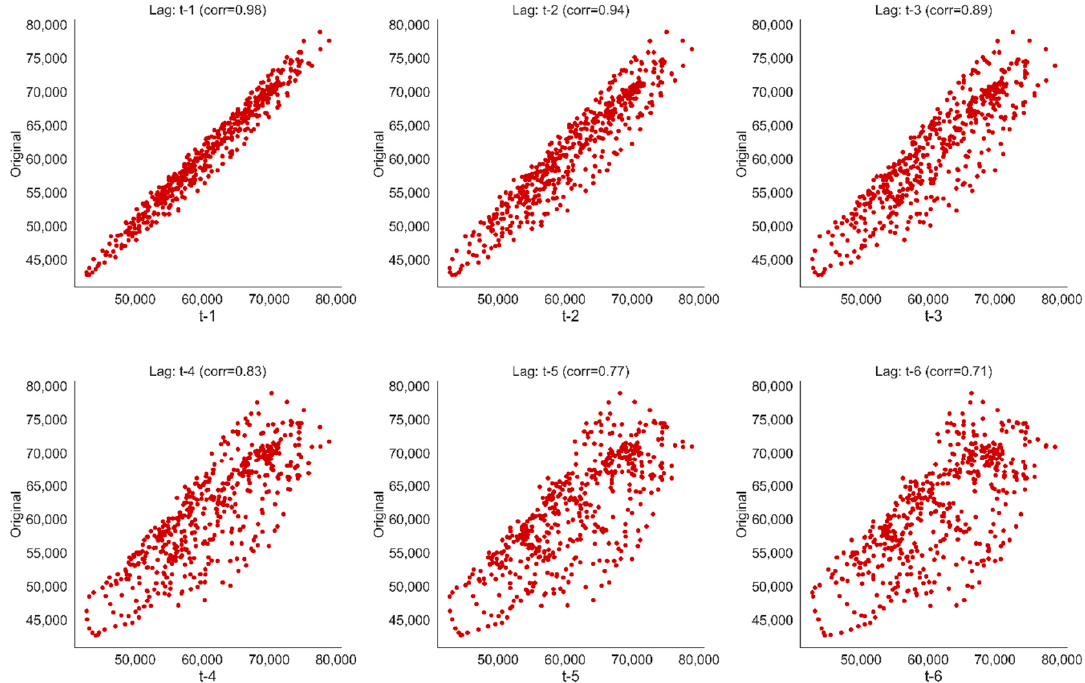
Figure 7. Correlation with previous 6 load lags.